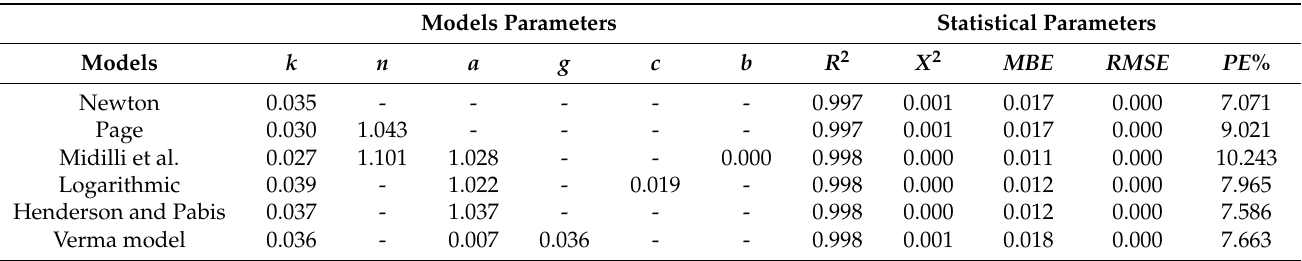
Table 2. Values of the parameters of the models for astringent persimmon “Rojo Brillante”. Models Parameters Statistical Parameters